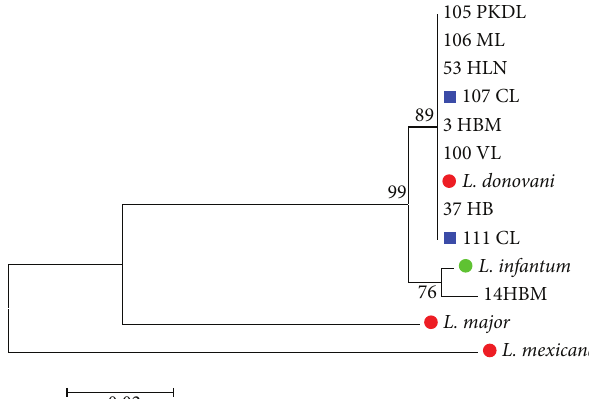
Figure 3: Phylogenetic tree of COII cloning sequences. Phylo- genetic tree based on a fragment of 570 bp of COII gene of Leishmania parasite. Sequence dataset was analyzed using MEGA 5, the neighbor-joining (NJ) method, and bootstrap analysis (1,000 replicates) based on the ClustalW algorithm. Significant bootstrap- ping values ( > 70%) are shown on the nodes. Blue square: colonies numbers 1 and 6 as representative sequences of 108 cytochrome oxidase II cloned sample; purple triangle: colonies numbers 1, 2, and 3 as representative sequences of 109 cytochrome oxidase II cloned sample; dark red lozenge: colonies numbers 6, 7, and 22 as represen- tative sequences of 110 cytochrome oxidase II cloned sample; red cir- cle: Leishmania GenBank reference sequence ( L. donovani GenBank accession number AY660023; L. major GenBank accession number EF633106; L.mexicana GenBank accession number HQ586845.1